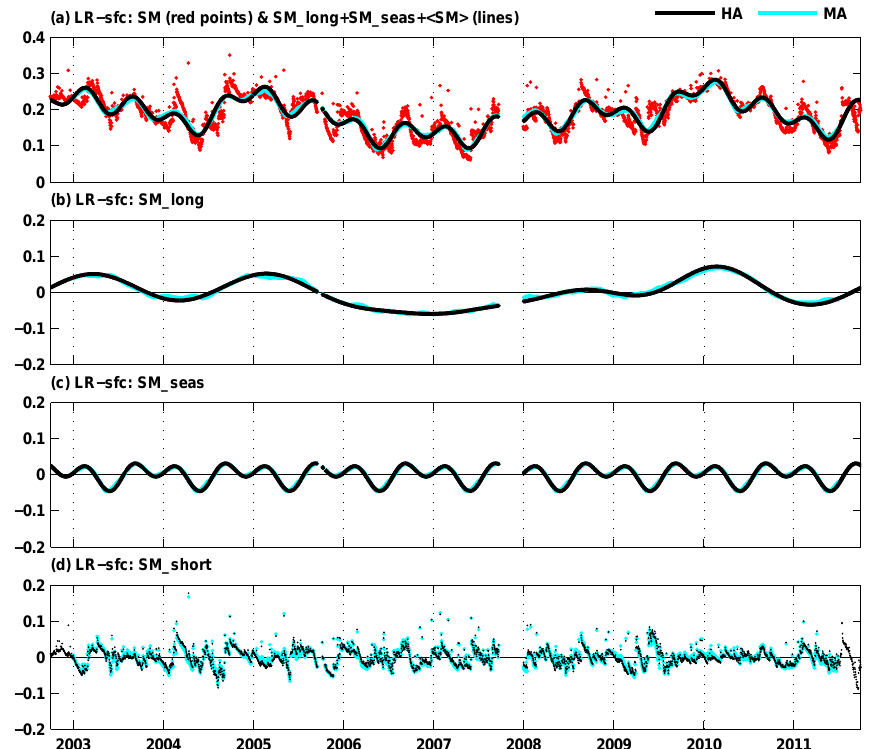
Figure 2. Decomposition of the Catchment near-surface soil moisture time series at Little River, using the harmonic (HA; black) and moving average (MA; cyan) methods, for (a) the original time series (red dots) and the sum of SM long + SM seas + the long-term mean soil moisture (solid lines), and the individual components (b) SM long , (c) SM seas , and (d) SM short .